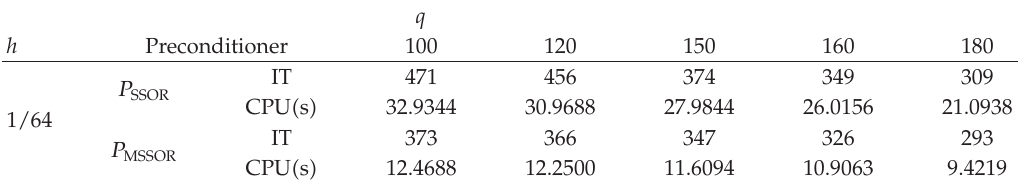
Table 3: Iteration numbers for the two-dimensional Helmholtz equations for h (cid:10) 1 / 64 and p (cid:10) 4100, using COCG with the preconditioner P SSOR and P MSSOR .